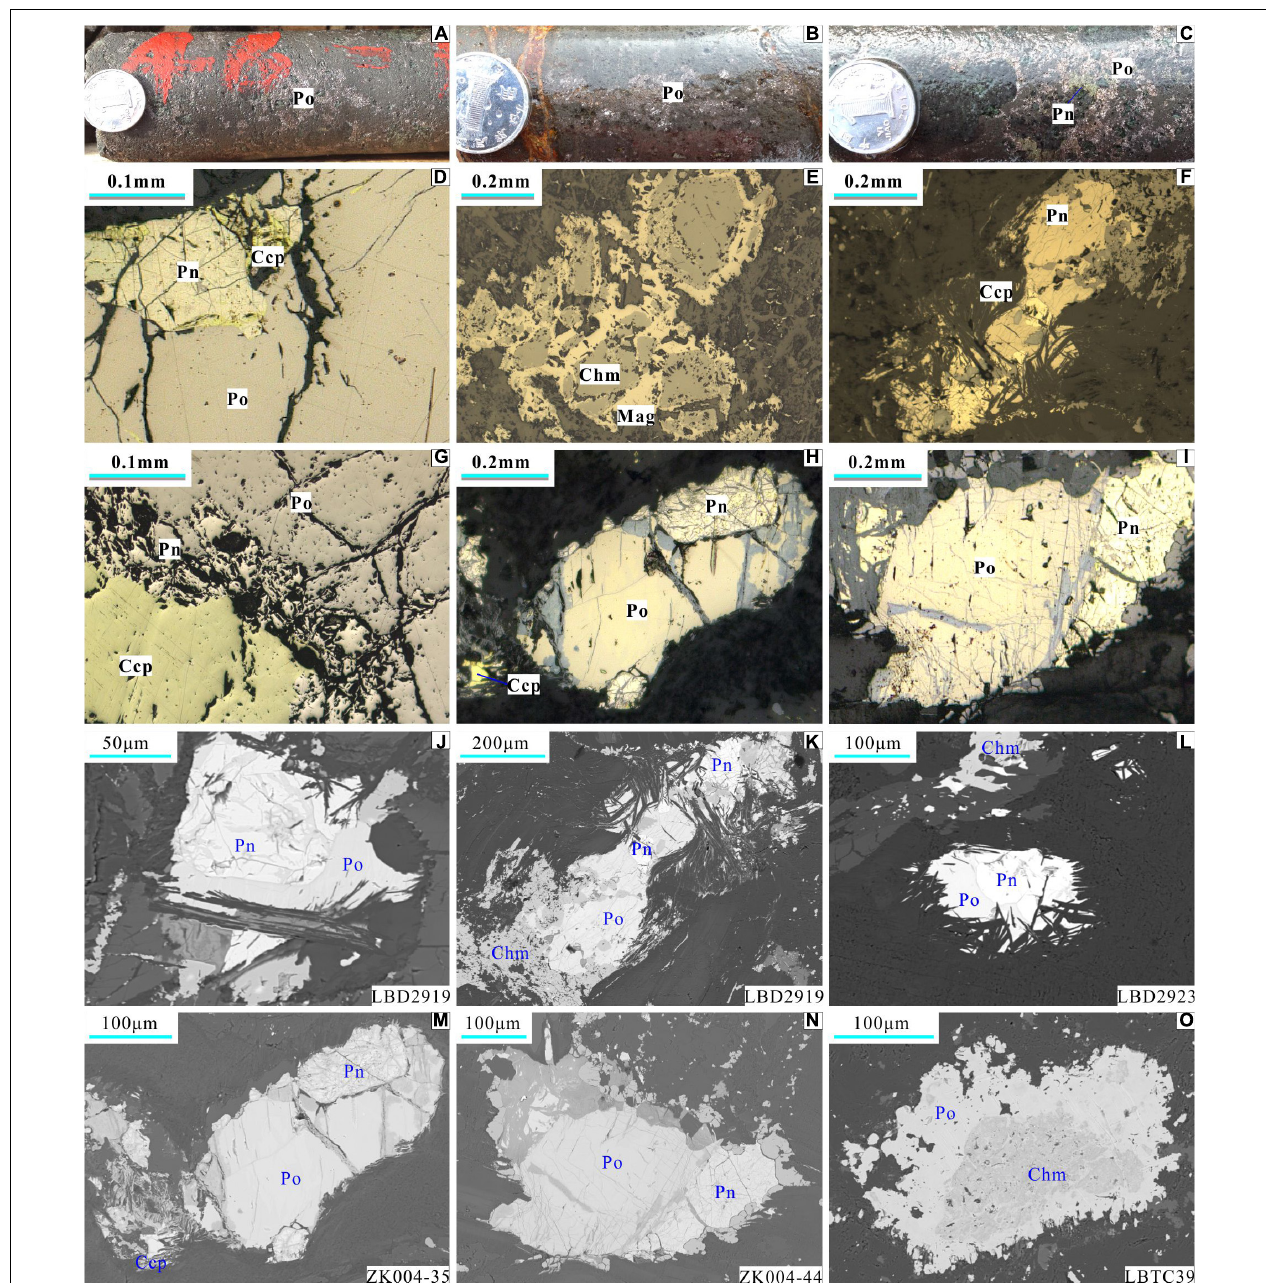
FIGURE 4 | Photos of outcrops and microphotographs of representative ores from Lubei deposit. (A) pentlandite in olivine pyroxenolite; (B) pentlandite in olivine pyroxenolite with limonitization vein; (C) Pn and Po in pyroxenolite; (D) Pn, Po, and Ccp co-occurrence; (E) Chm surrounded by Mag; (F) Pn coexisted with Ccp, and Pn in crack; (G) Pn, Po, and Ccp co-occurrence; (H) oxidized Po and Pn in crack; (I) oxidized Po; (J) Pn surrounded by Po; (K) Pn coexisted with Ccp, and Pn in crack; (L) Pn coexisted with Po; (M) oxidized Po and Pn in crack; (N) oxidized Po; (O) Chm surrounded by Po. Pn, Pentlandite; Po, Pyrrhotite; Chm, chromite; Ccp, chalcopyrite; Mag,